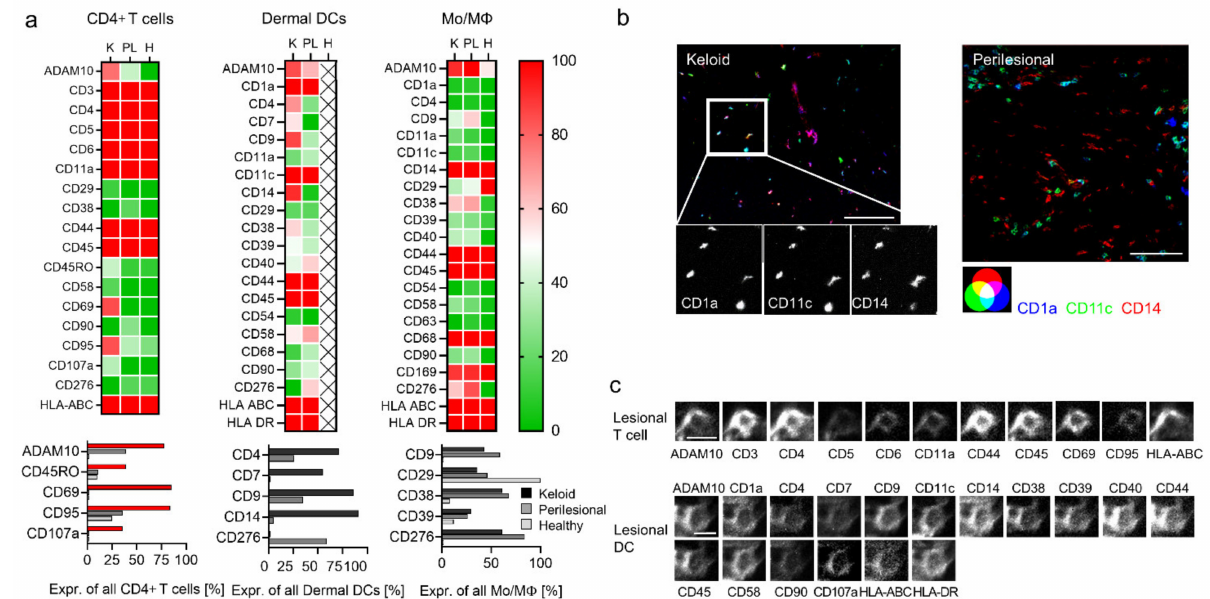
Figure 3. Deep phenotyping reveals activated T cells and inflammatory DCs in keloids. ( a ) Deep phenotyping of immune subtypes in the keloid (K), perilesional (PL) and control (H) skin sections are shown for indicated markers in heat maps (upper panel). The color code from red (100) to green (0) displays the expression intensity of specific antigens in percentage in all cells of a certain immune subtype. Markers showing major differences in their expression intensity are depicted separately in a bar diagram (lower panel). ( b ) Fluorescence co-localization images for CD1a (blue), CD11c (green), CD14 (red), the characteristic markers for inflammatory DCs. Close-up images of single markers indicate the triple expression in each cell in the keloid sample. Scale bars = 50 µ m. ( c ) Representative protein profile of individual cells (lesional T cell and lesional DC) in keloid tissue by MAA. The two panels show the same section, stained with 11 and 17 antibodies, respectively. Scale bars = 10 µ